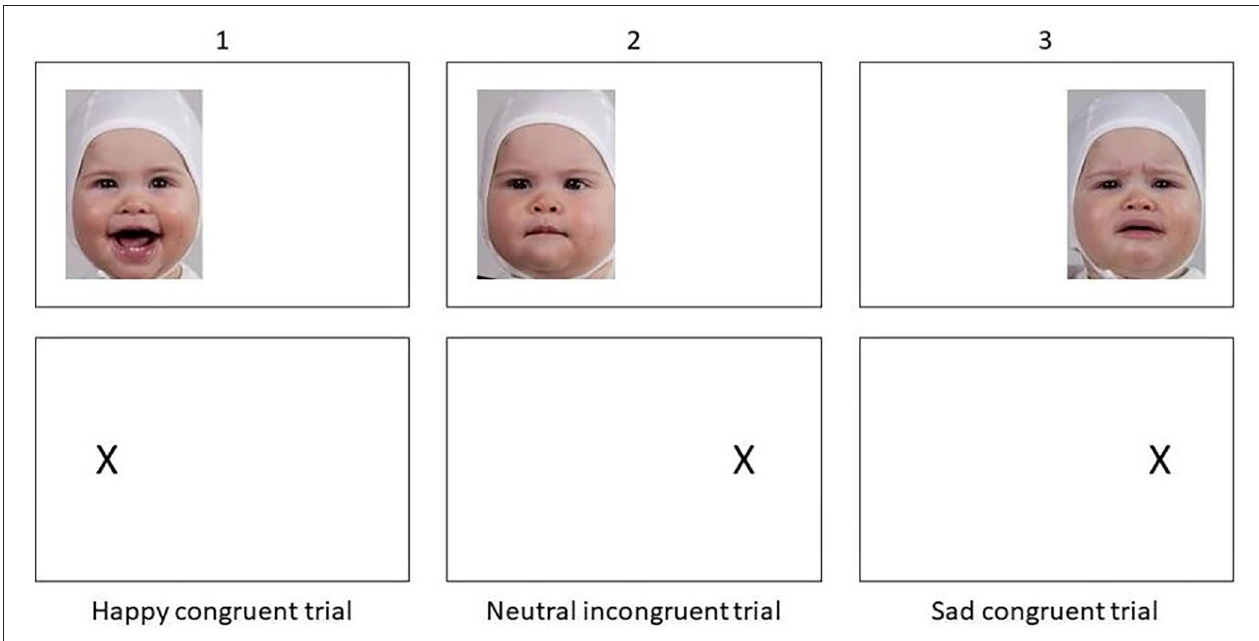
FIGURE 1 | Example of trials from the dot-probe